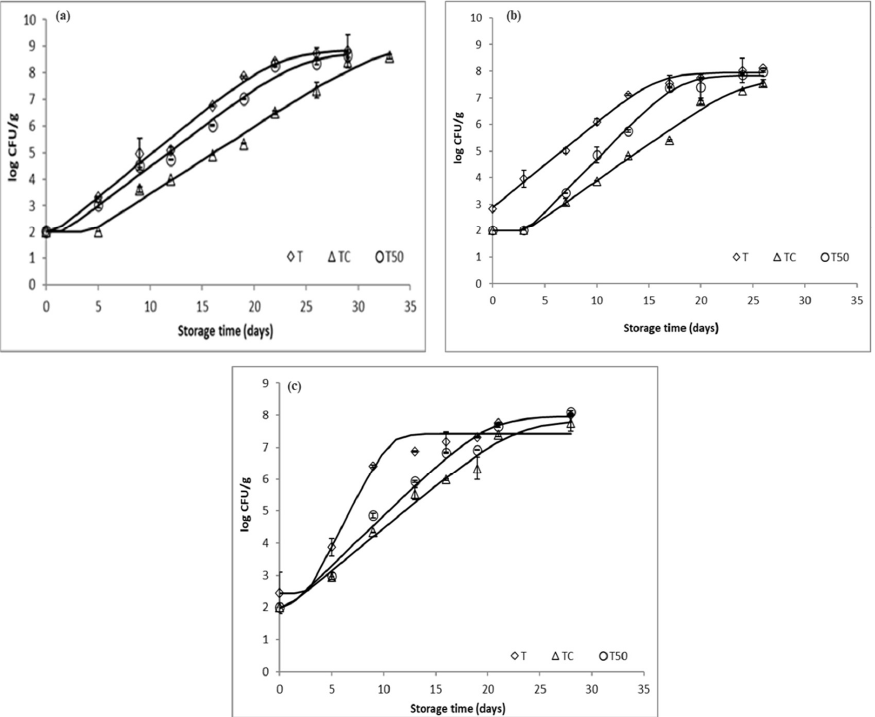
Figure 1. Growth of total viable counts (TVCs) in whole gilthead sea bream slaughtered in ( a ) September 2020, ( b ) January 2021, and ( c ) April 2021 during storage at 0 °C ( ◇ T, △ TC, ○ T50) ( p < 0.05). Counts of Pseudomonas spp. remained at the detection limit (2.0 log CFU/g) for ap- proximately 4–5 days for TC samples, while counts increased throughout storage for T and T50 samples, reaching 6 log CFUg −1 after 14, 16, and 21 d for the T, T50, and TC sam- ples, respectively (Figure 2a). Similar results concerning the growth of Pseudomonas spp. were reported in other studies, showing a similar effect of ice slurry as compared with conventional ice [35]. The Pseudomonas spp. growth rates had significantly lower values for TC (0.24 d −1 ) samples than for T (0.36 d −1 ) and T50 (0.33 d −1 ) samples ( p < 0.05), showing that slurry ice was effective in controlling and in fact slowing the growth of Pseudomonas spp. as compared with conventional ice when the sea water temperature was 27 °C.